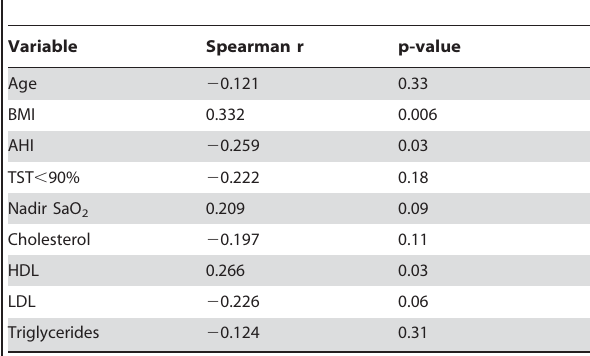
Table 2. Correlations of d-ROMs metabolites.